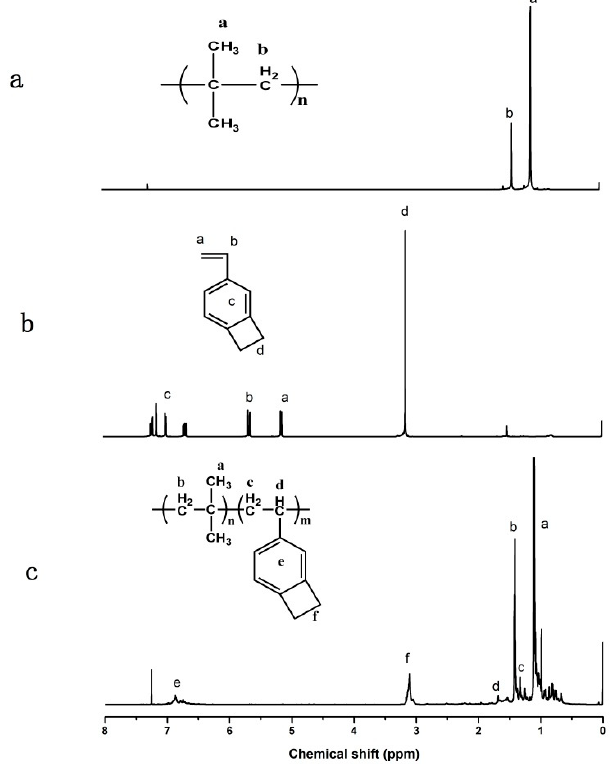
Figure 1. 1 H NMR spectra of polyisobutylene (PIB) ( a ), 4-VBCB ( b ), poly(IB- co -4-VBCB) ( c ).